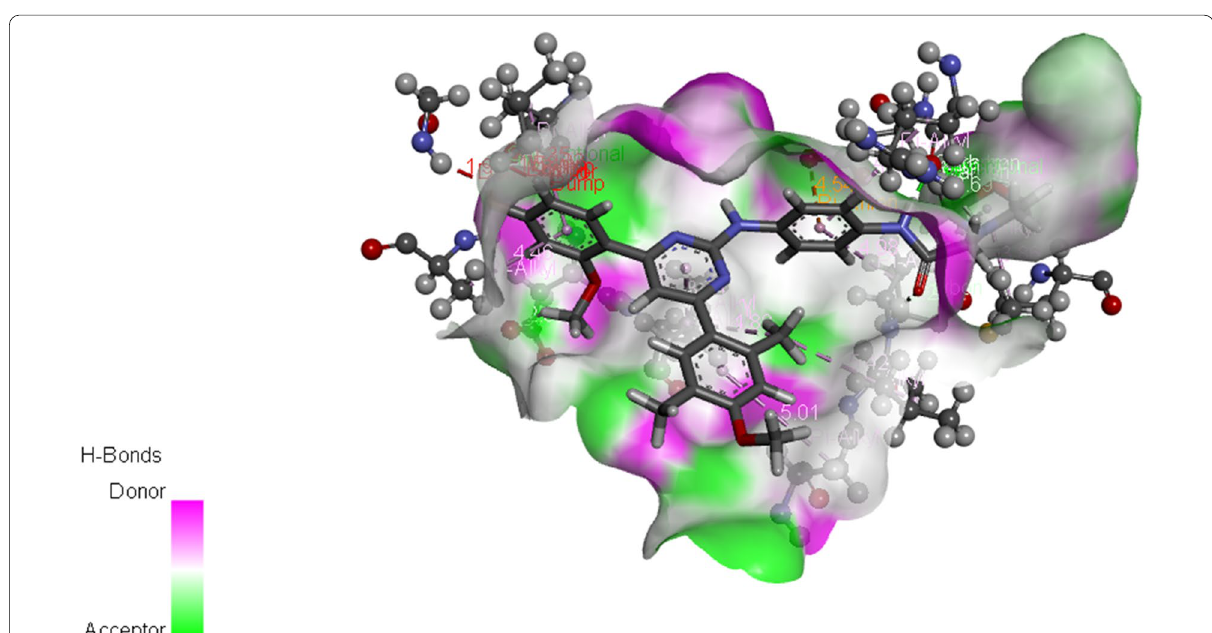
Fig. 12 3D structure of the designed compound 5 interactions with VEGFR-2